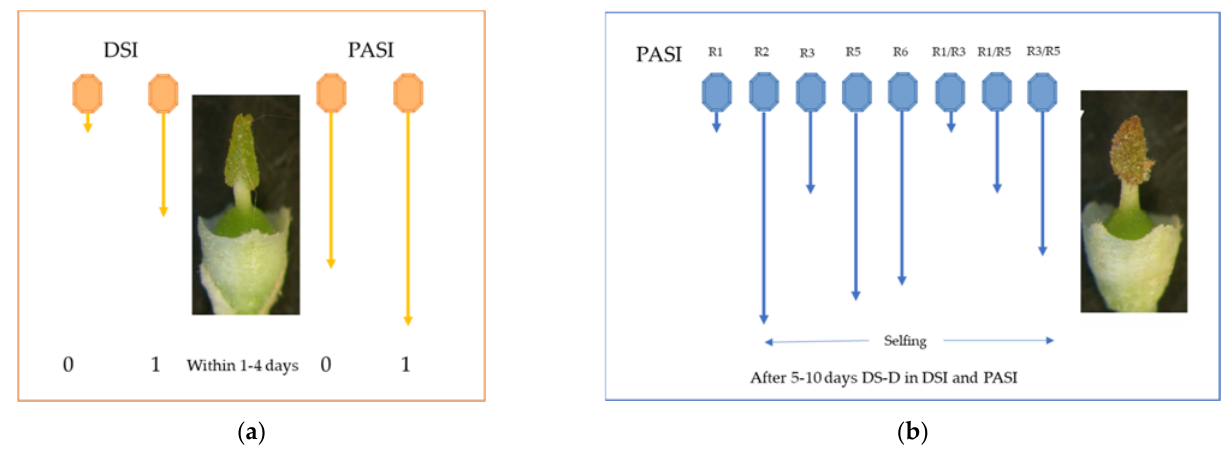
Figure 6. Temporal schemes of the events following pollination ( a ) with compatible pollen within four days, DSI acts, then PASI, leading to 0 ‐ 0 and 1 ‐ 0; ( b ) without compatible pollen after 5 to 10 days, DS ‐ D runs for PASI pollen determinants (R1 to R35), leading to pollen tube growth even when incompatible with ovary, but depending upon the S ‐ allele pair in PASI. The length of the blue arrows indicates that the pollen tube growth in selfing is proportional to the risk of DS ‐ D. Pictures are from Adela Olmedilla (Granada, Spain, with permission).